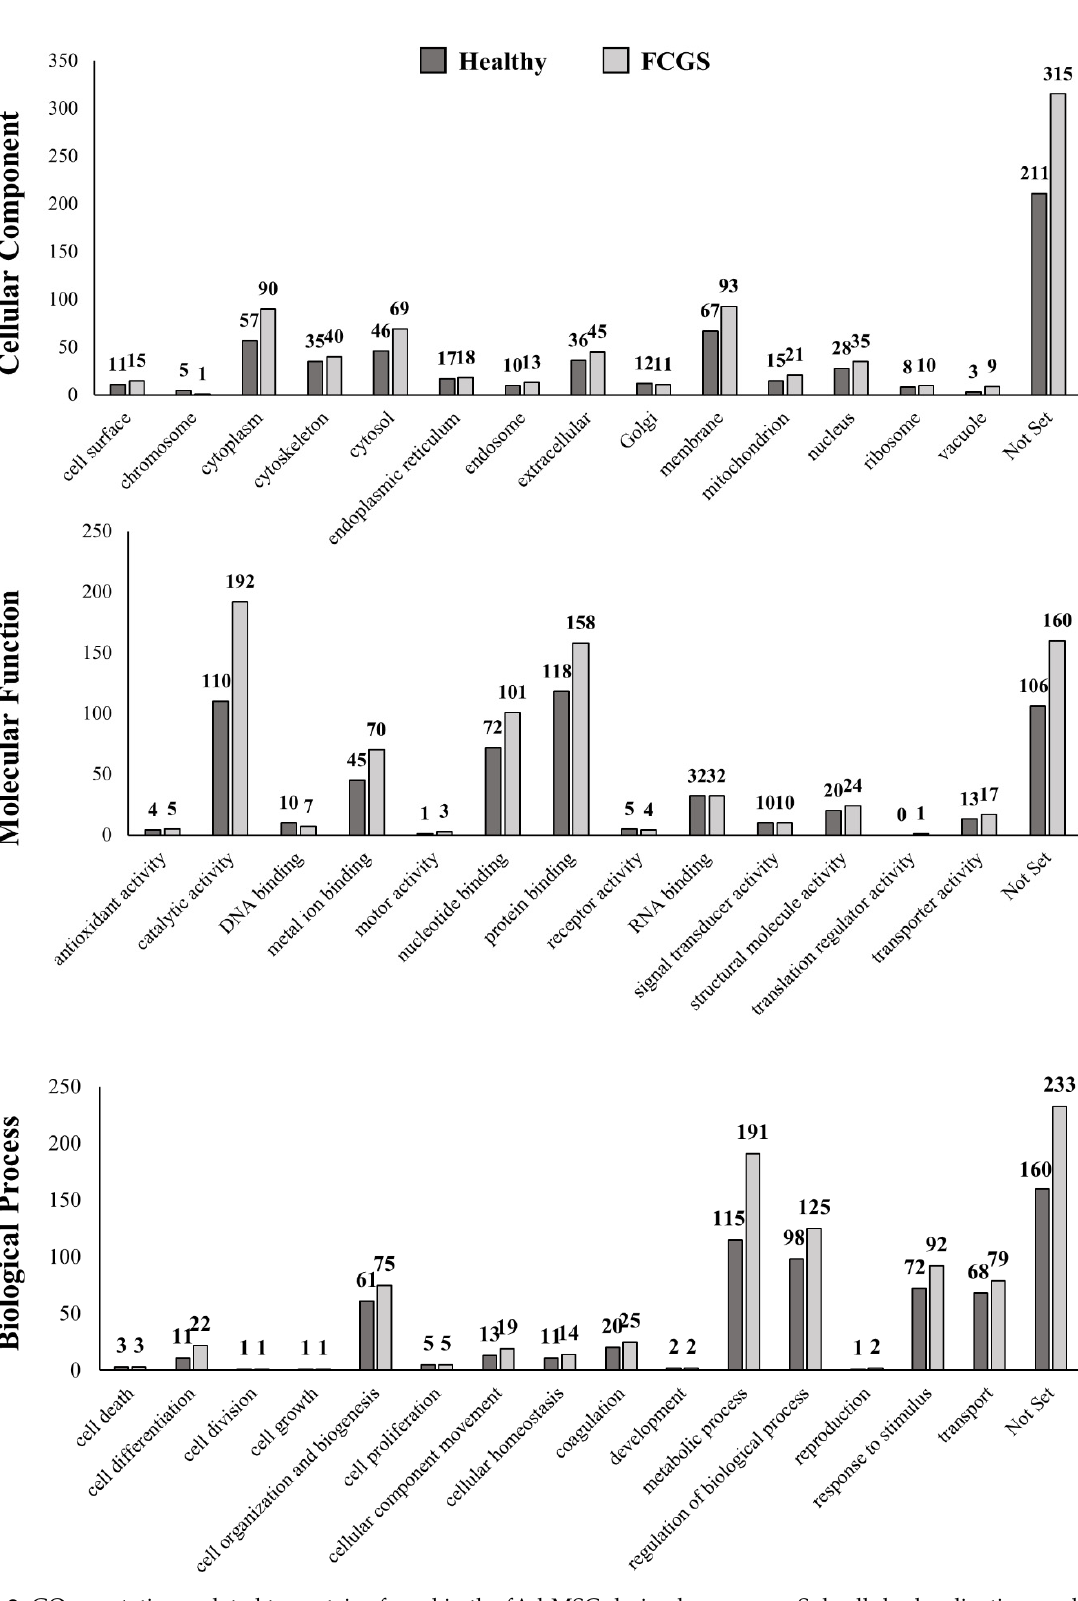
Figure 2. GO annotations related to proteins found in the fAd-MSC-derived exosomes. Subcellular localization, molecular function, and biological processes related to the identified proteins. A single protein can be included in different subgroups. “Not set” indicates that these proteins are not classified in any of the parameters described according to GO (more information is provided in Table S1).